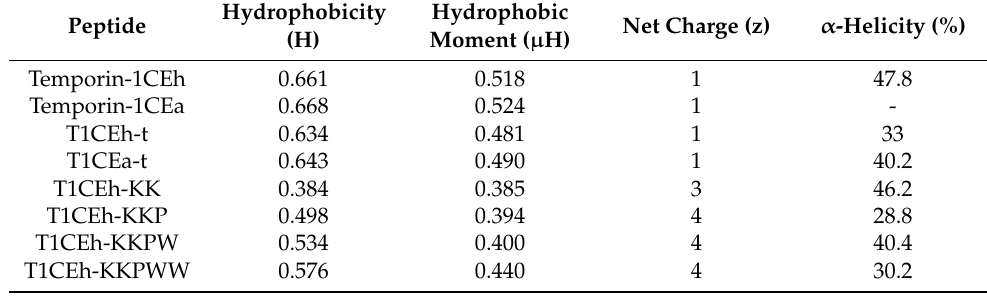
Table 3. Physicochemical characteristics of Temporin-1CEh and its analogues. Each amino acid chain is assigned a value, positive or negative, according to its hydrophobicity. These values are used to weigh vectors for each residue as they are displayed around the helix. The summation of the vectors is the hydrophobic moment. The sum of the hydrophobicity values divided by the number of the residues. This value is hydrophobicity. Alpha-helicity was calculated from the data of CD value for respective peptides in 50/50 TFE/H 2 O ( v / v ) environment by the Bestsel website [36]. It has not found published data of α -helicity value of Temporin-1CEa.